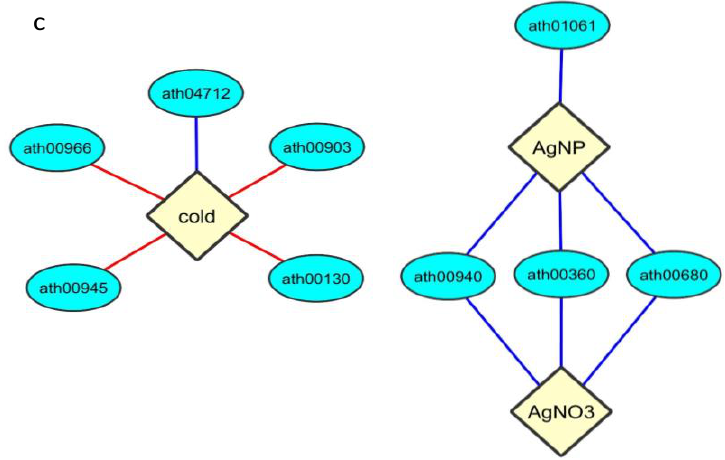
Figure 4. PFAM protein domain, InterPro protein class, and KEGG pathway enrichment of the genes with more than two fold expression changes for all the six abiotic stresses. ( a ) Visualization of 32 unique enriched PFAM protein domain across the six abiotic stresses; ( b ) Display of 44 definite enriched InterPro classes associated with the six stresses; ( c ) Nine enriched KEGG pathways in six stresses were shown. The enrichment results were visualized using Cytoscape 3.1.0, where blue edges denote enrichment for up-regulated genes and red edges denote enrichment for down-regulated genes. The description of PFAM protein domain, InterPro protein class, and KEGG pathway were in Tables S2, S4 and